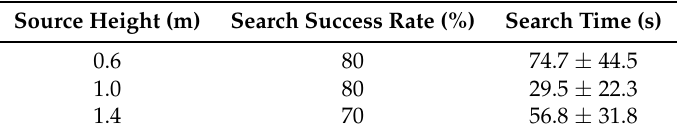
Table 3. Results of the three-dimensional CPT experiment. The search time is expressed in terms of the mean and standard